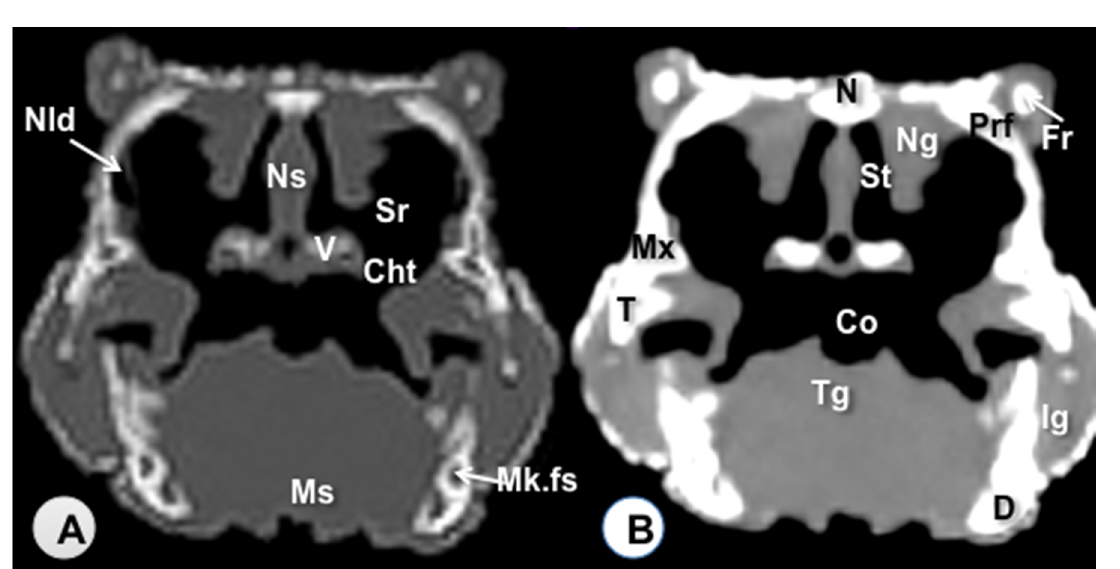
Figure 2. Transverse CT image of the head of Varanus komodoensis at the level of the nasal bone corresponding to line II. ( A ) CT bone window. ( B ) CT soft tissue window. These images are displayed so that the right side of the head is to the viewer’s left and the dorsal view is at the top. N: Nasal bone. Prf: Prefrontal bone. Ns: Nasal septum. Ng: Nasal glands. St: Stammteil, V: Vomer. Sr: Subconchal recess. Cht: Choanal tube. Nld: Nasolacrimal duct. Mx: Maxillary bone. T: Tooth. Co: Cavum oris. Tg: Tongue. Ms: Musculus intermandibularis + Musculus geniohyoideus + Musculus pterygoideus + Musculus hyoglossus. D: Dentary bone. Mk.fs: Meckelian fossa. Ig: Infralabial glands. Fr: Frontal bone.